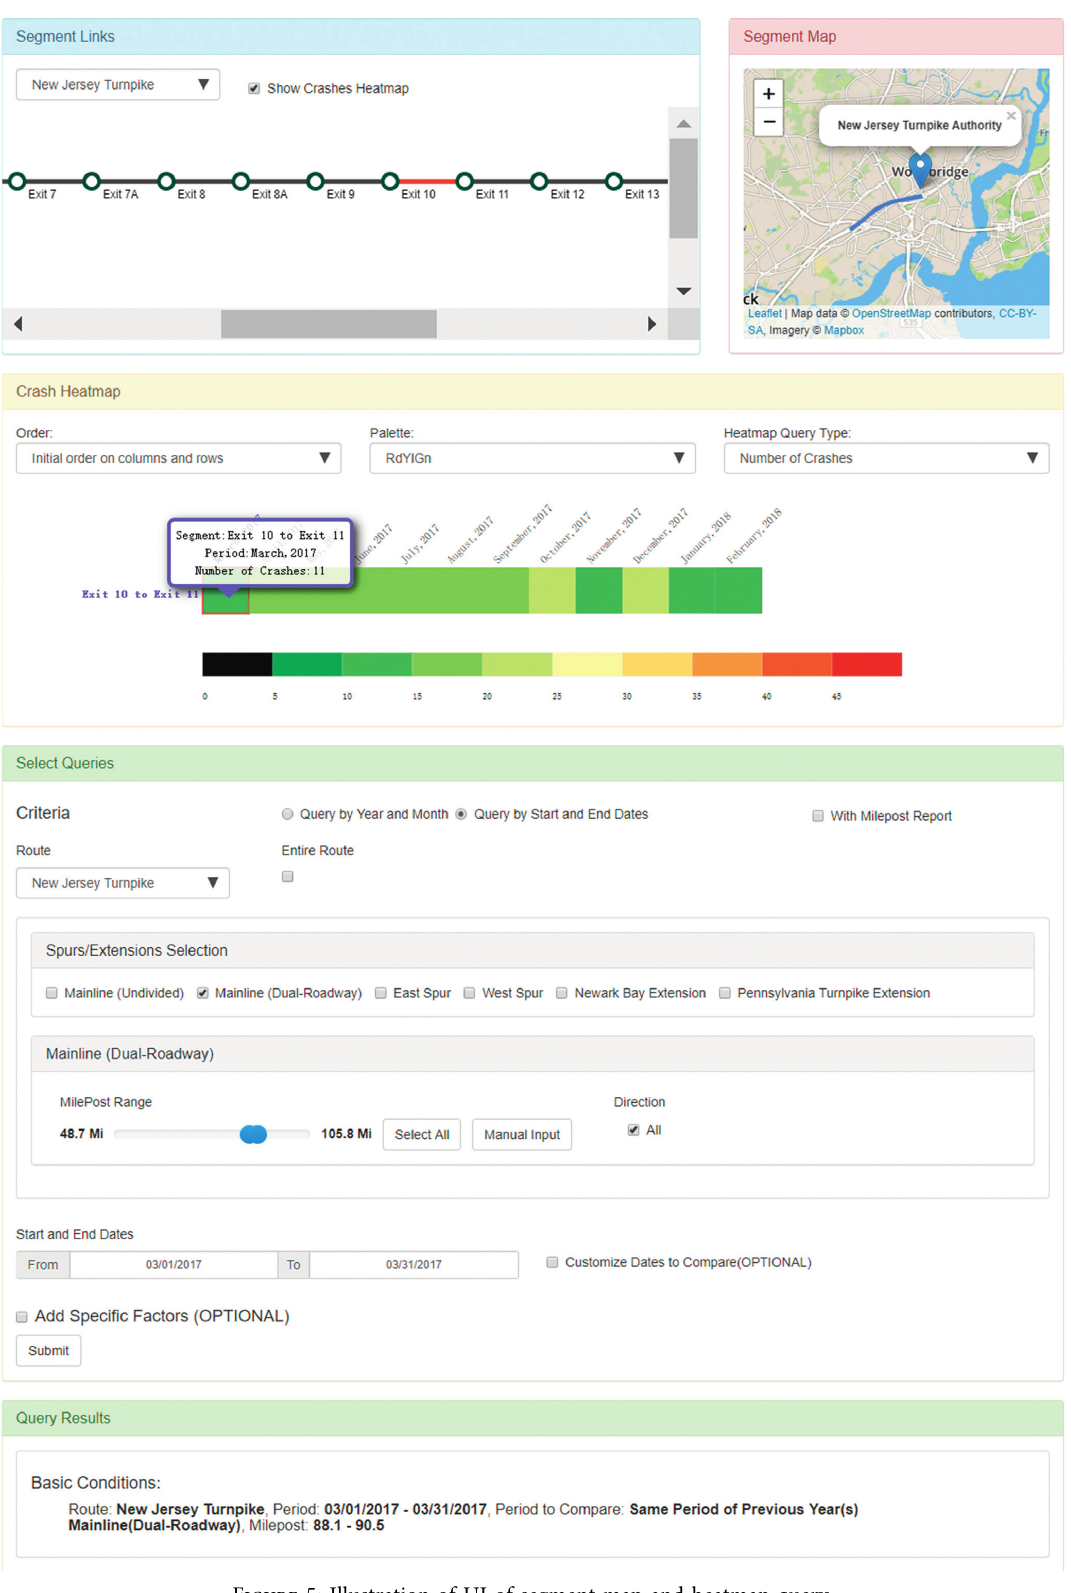
Figure 5: Illustration of UI of segment map and heatmap